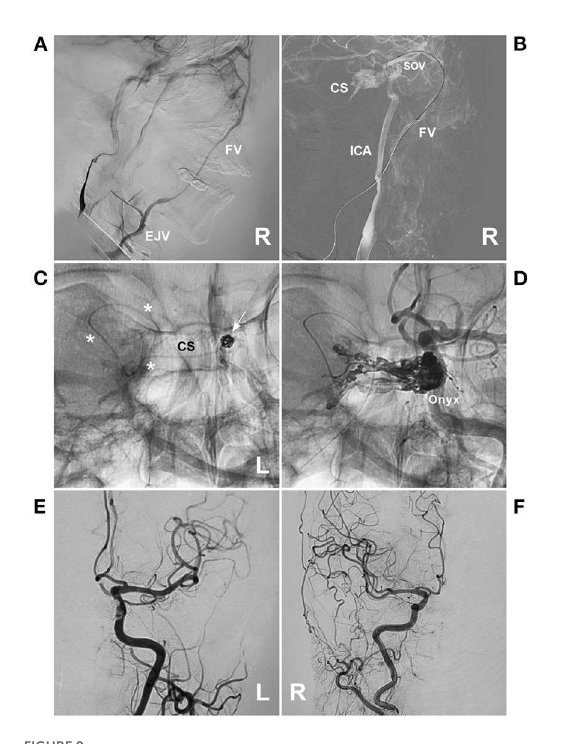
Operative angiography of CS-DAVF embolized via the trans-EJV-FV-SOV route. (A) Venous phase angiography of the right ICA shows the right FV into the EJV. (B) Venous navigation roadmap shows that the microcatheter passed through the right angular vein into the SOV. (C) X-ray image shows the microcatheter (asterisks) passing through the intercavernous sinus from the right into the left CS to perform coiling (arrow). (D) Unsubtracted angiography shows the combined use of Onyx to occlude the CS-DAVF. (E, F) Post-TVE angiographies of the left carotid artery (E) and right carotid artery (F) show complete occlusion of the DAVF. CS, cavernous sinus; DAVF, dural arteriovenous fistula; EJV, external jugular vein; FV, facial vein; ICA, internal carotid artery; L, left; R, right; SOV, superior ophthalmic vein; TVE, transvenous